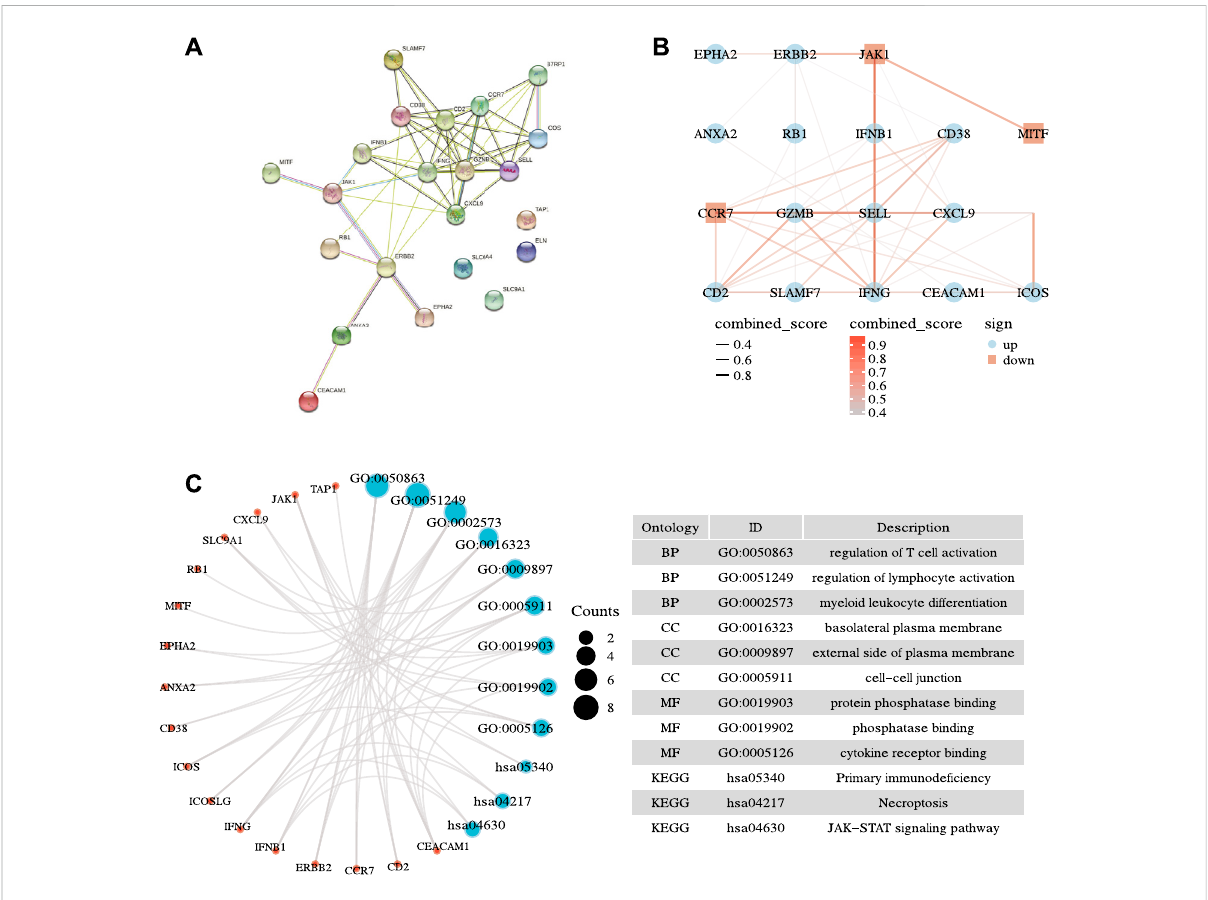
FIGURE 3 Biological function analysis. (A) Interactions among candidate genes shown by the PPI network obtained by using the STRING database. (B) Correlation network of selected candidate genes (different color depths represent thestrength of the correlation coef fi cient. Red represents down- regulation, and blue represents up-regulation). (C) Results of GO and KEGG